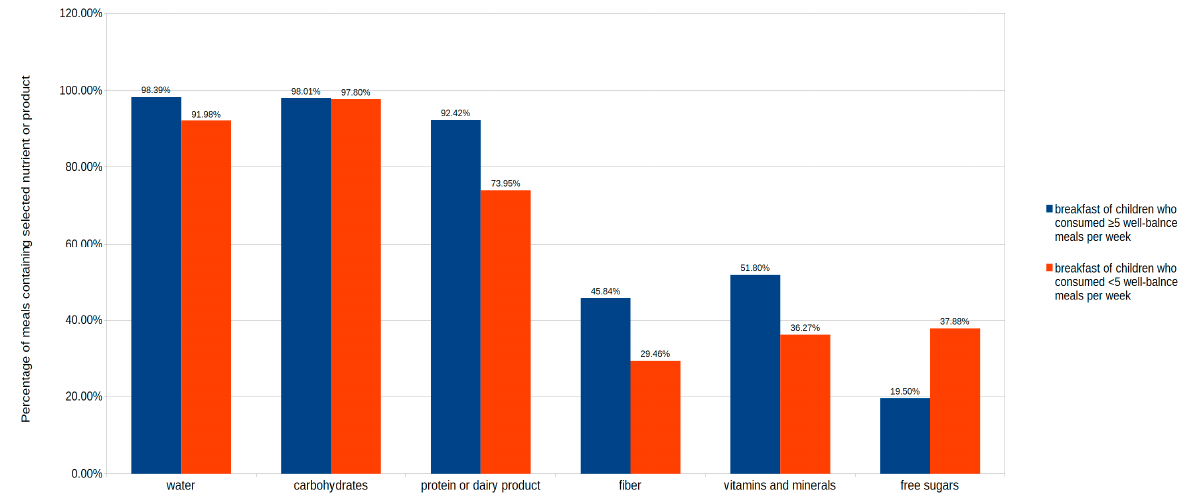
Figure 3. A qualitative assessment of breakfast composition in groups different by frequency of consumption of well- balanced breakfast.